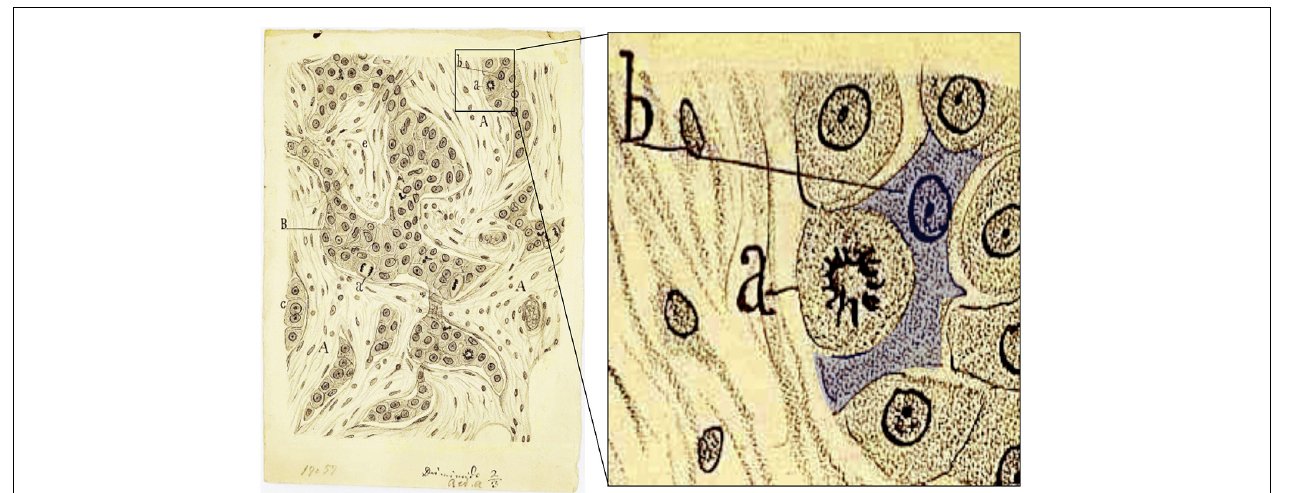
epithelial–mensenchymal transition, a first step in the metastatic cascade: “ The cells are not attached to each other ... This explains their invasive ability, since free of intercellular cement, they can migrate through the connective tissue ” (from López-Novoa and Nieto, 2009, with